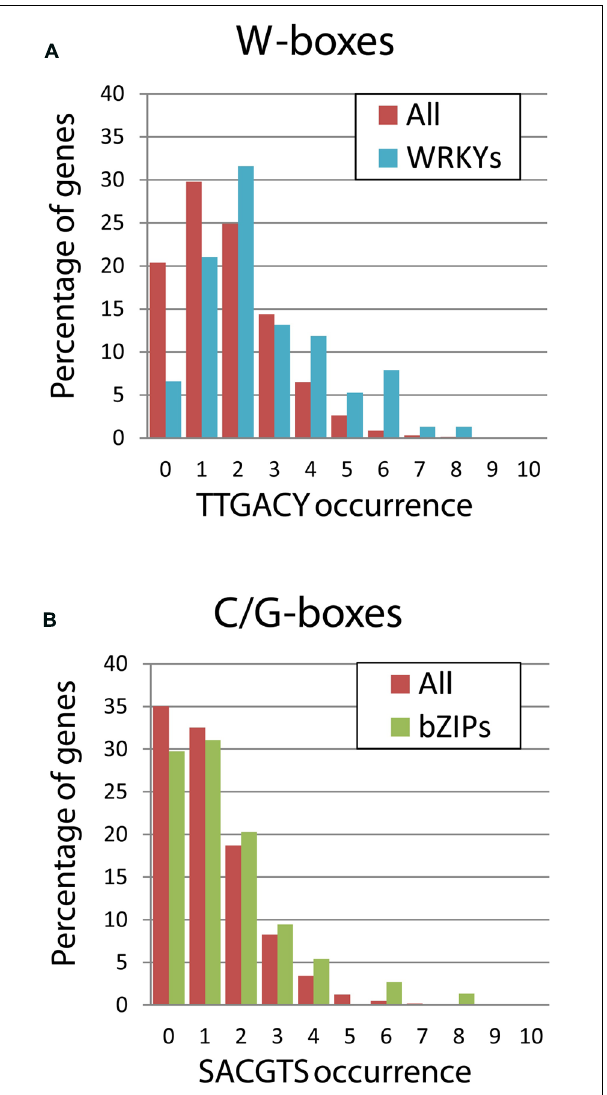
FIGURE 4 | Frequency of cis -element distribution within the 3-kb upstream of coding sequences. The occurrence of the cis -elements was calculated only for the positive strand using the Patmatch tool in theTAIR website. Red bars refer to the whole set of 33,602 annotations of the TAIR10 Genome Release, while green and blue bars indicate the subsets including only bZIPs or onlyWRKYs genes, respectively. (A) The occurrence ofW-boxes was determined using aTTGACY motif, whereY indicates pyrimidine.The enrichment ofW-boxes in theWRKY promoters is remarkable, while only fewWRKY promoters carry noW-boxes. (B) The occurrence of the G- and C-boxes, the preferred cis -elements bound by plant bZIPs, was determined using a SACGTS motif, where S indicate strong bases (C and G). In contrast, no increase of bZIP-binding sites in their promoters can be